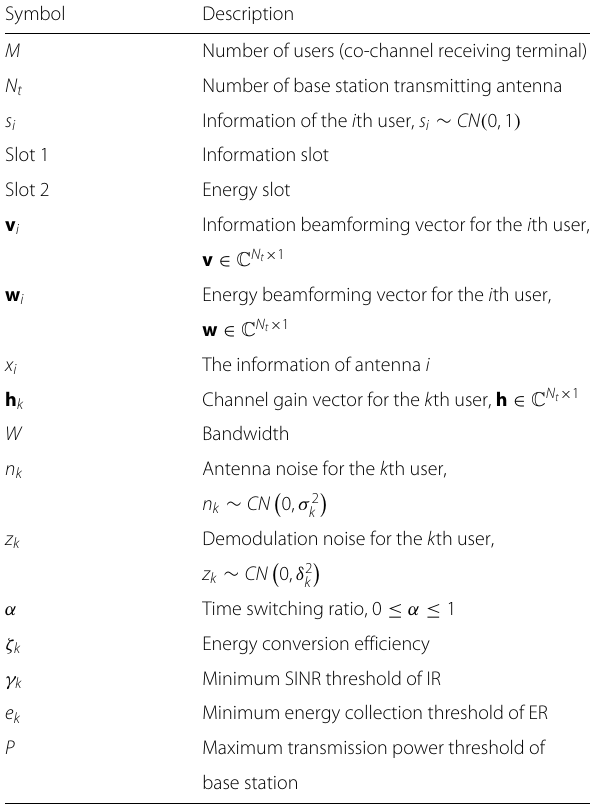
After the information passes through the quasi-static wireless channel, the information received by the k th user becomes